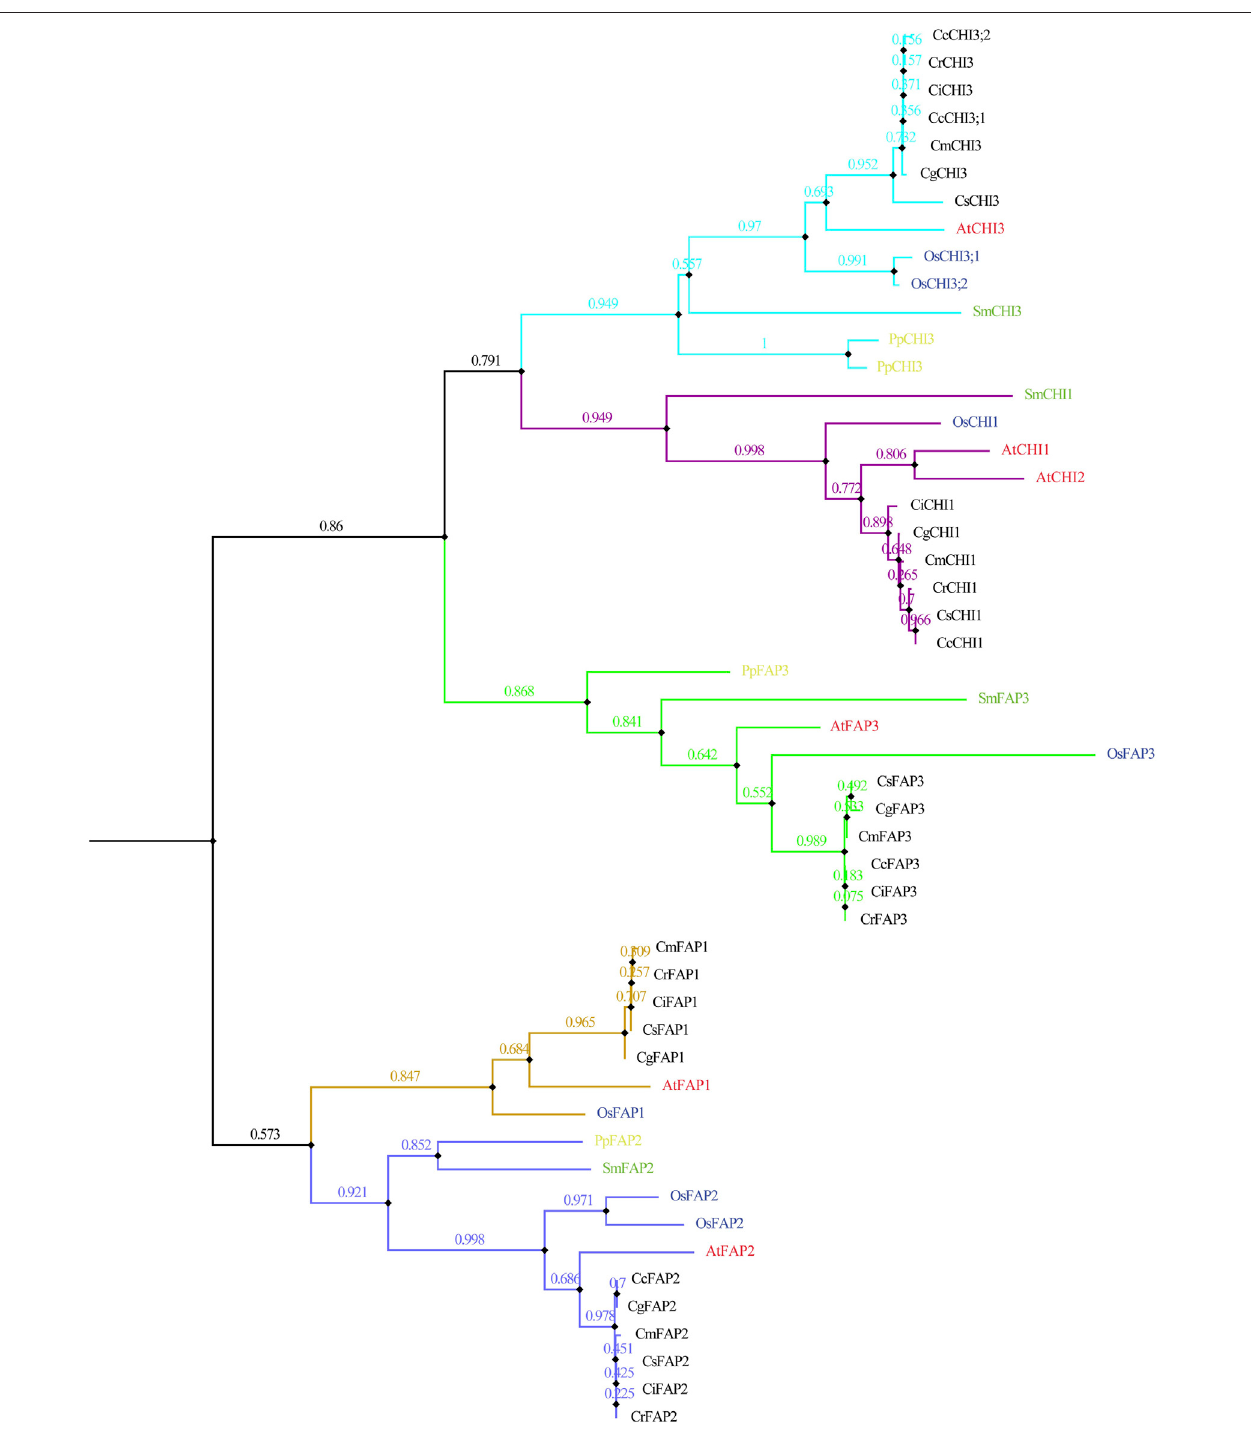
FIGURE 2 | Phylogeny of representative CHI genes from the 10 plant species based on the protein sequences. Sm represents S. moellendorf fi i, Pp represents P. patens , Osrepresents O. sativa , Atrepresents A. thaliana ,Cc represents C. clementina , Cgrepresents C. grandis , Cr represents C.reticulata , Cm represents C.media , Cr represents C. reticulata , and Cs represents C. sinensis.